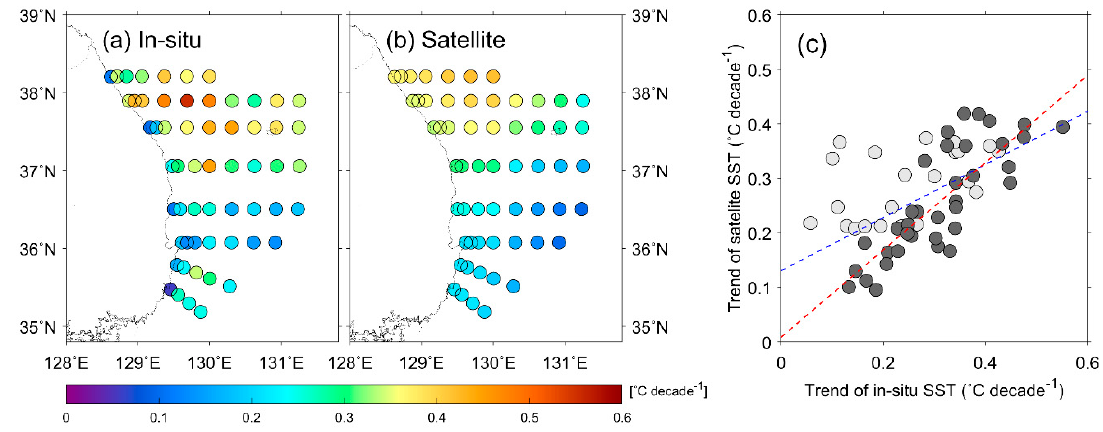
Figure 5. ( a ) Trends ( ◦ C decade − 1 ) from in-situ near-surface water temperatures measurements, where the black circles represent the trends at 95%-confidence level; ( b ) same but for satellite SSTs; and ( c ) comparison between trends from in-situ and satellite SST, where the light (dark) grey dots represent the points close to (far from) the coast and the blue (red) dashed line represents its least squares linear fit (blue line: y = 0.49x + 0.01 (R 2 = 0.36), red line: y = 0.80x + 0.00 (R 2 = 0.67)).